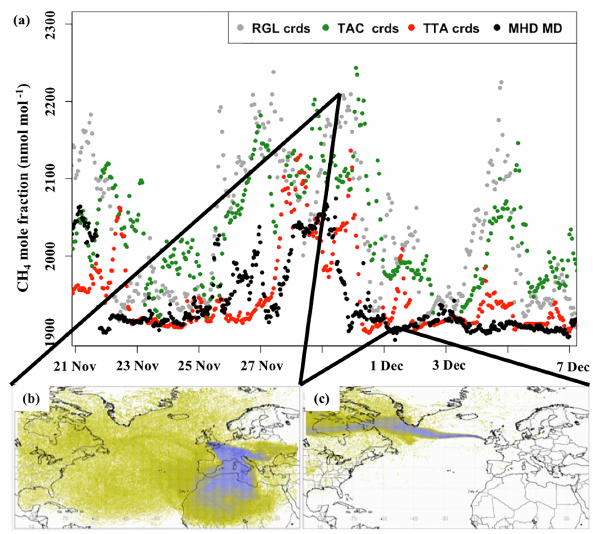
Figure 10. Examples of (a) CH 4 mole fractions from 21 Novem- ber to 7 December 2014 (MHD MD discrete samples, CRDS val- ues 20min averages), and 2h air-history maps derived from NAME (b) for RGL, regionally polluted period, and (c) for MHD, baseline period. The air-history maps describe which surface areas (0–40m) in the previous 30 days impact the observation point within a par- ticular 2h period. Black lines in (a) indicate the data point that the air-history maps in (b) and (c) correspond